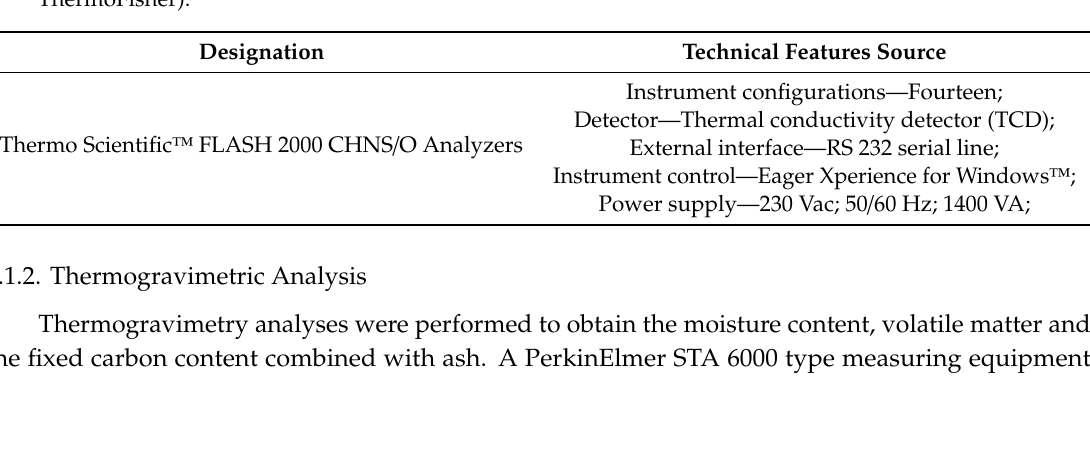
Table 2. Technical characteristics of the ThermoFisher Scientific Flash 2000 CHNS-O analyzer (Source: